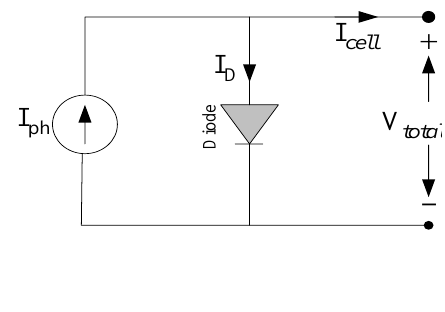
Figure 1. Solar cell electrical circuit